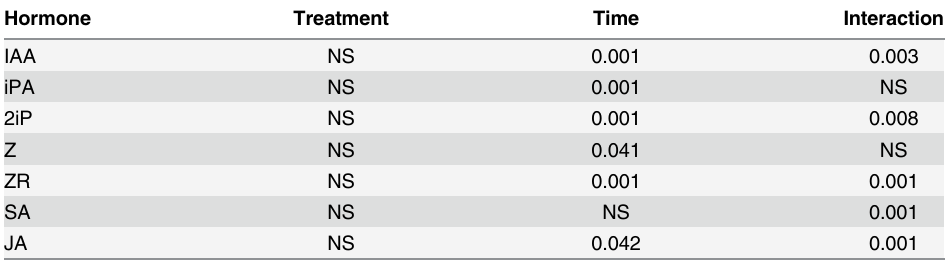
Table 1. P values of the analysis of variance (ANOVA) to test the effect of treatment, sampling time and its interaction on the levels of phytohormones in leaves of A . cordifolia . Hormone